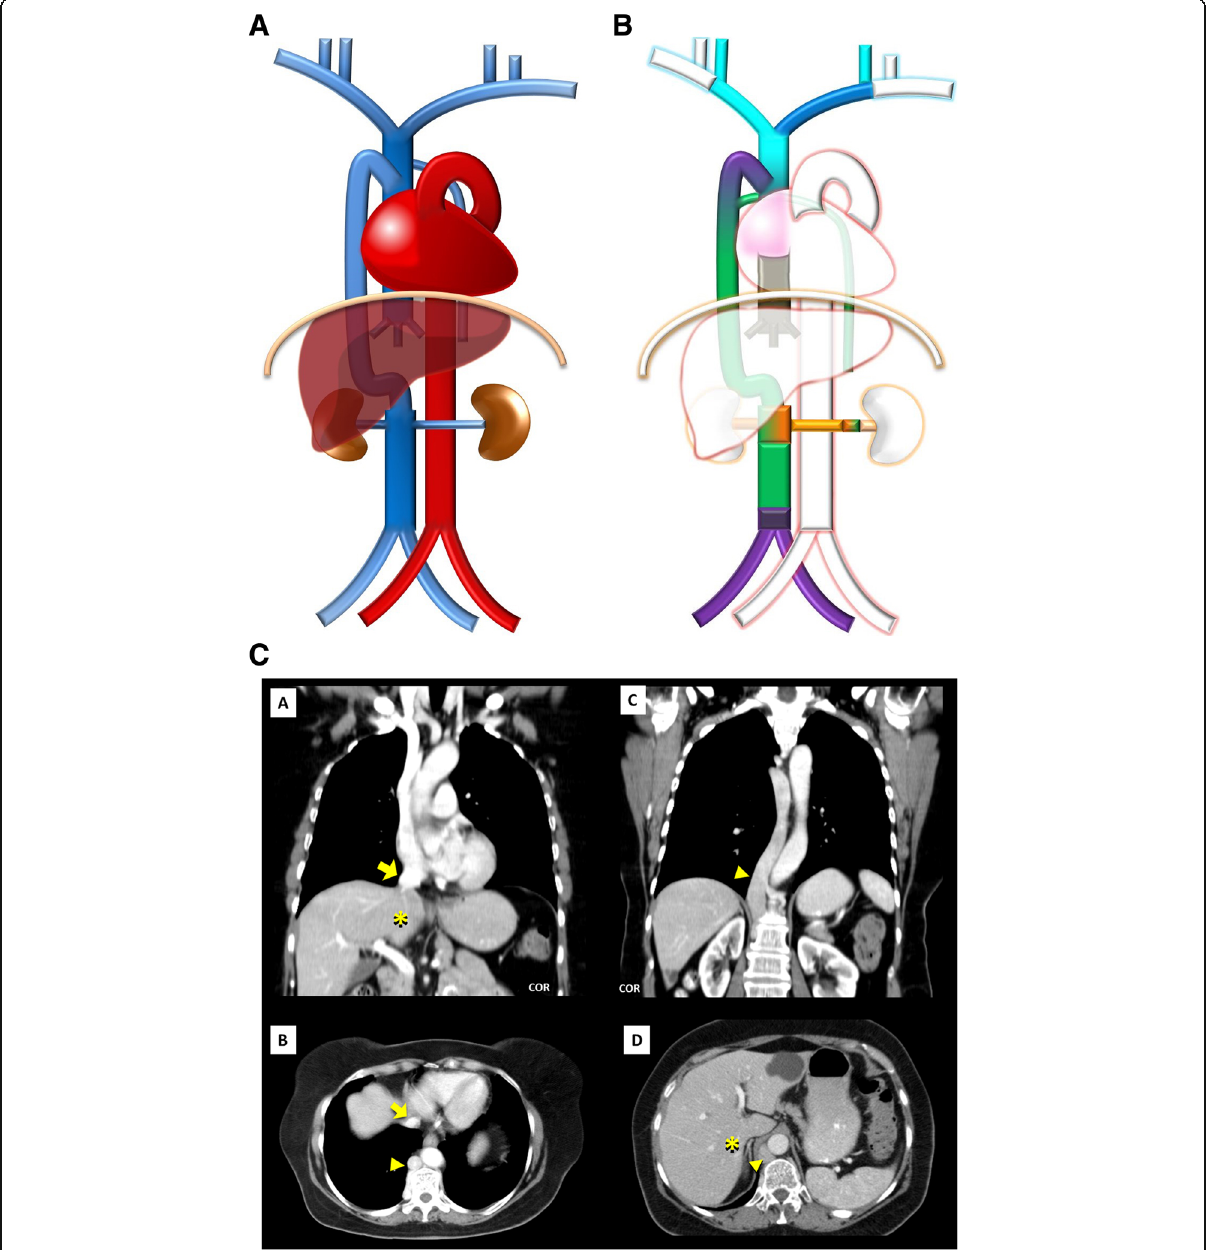
Fig. 9 a Interruption of the hepatic segment of the IVC/Azygos continuation of the IVC schematic. In this anomaly, the hepatic segment of the IVC is absent or hypoplastic, with the hepatic veins draining into the right atrium via the supra hepatic IVC and the renal portion of the IVC, receiving the blood return from the kidneys and lower extremities, by means of the azygos vein. b Interruption of the hepatic segment of the IVC/Azigos continuation of the IVC embryology schematic. The result from the failure to form of the right vitelline- sub cardinal anastomosis, with consequential regression of the right sub cardinal vein, causing the blood to directly shunt into the right supra cardinal vein. c Interruption of the hepatic segment of the IVC/Azygos continuation of the IVC imaging. Contrast-enhanced CT scan denoting absence of the hepatic segment of the IVC (asterisk), drainage of the hepatic veins into the right atrium via the suprahepatic IVC [A, B] and continuation of the renal portion of the IVC, passing posterior to the diaphragmatic crura to enter the thorax as the azygos vein (triangle), which drains to the SVC as normal [C,